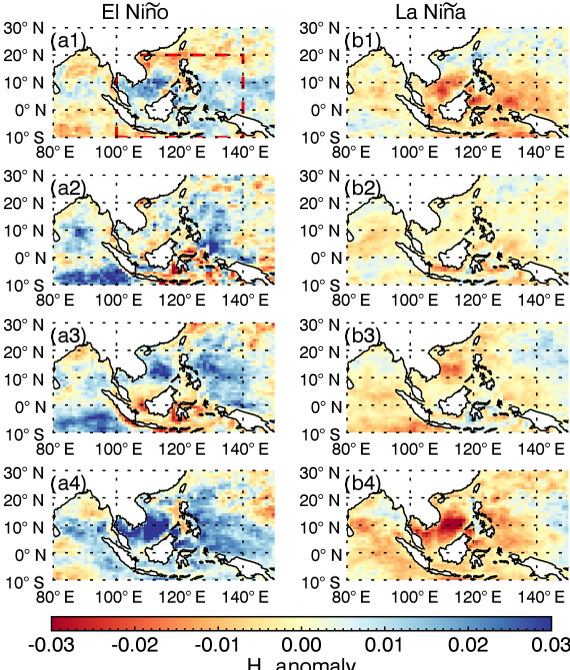
Figure 13. Spatial heterogeneity anomaly in El Niño and La Niña years, from top to bottom for MAM, JJA, SON, and